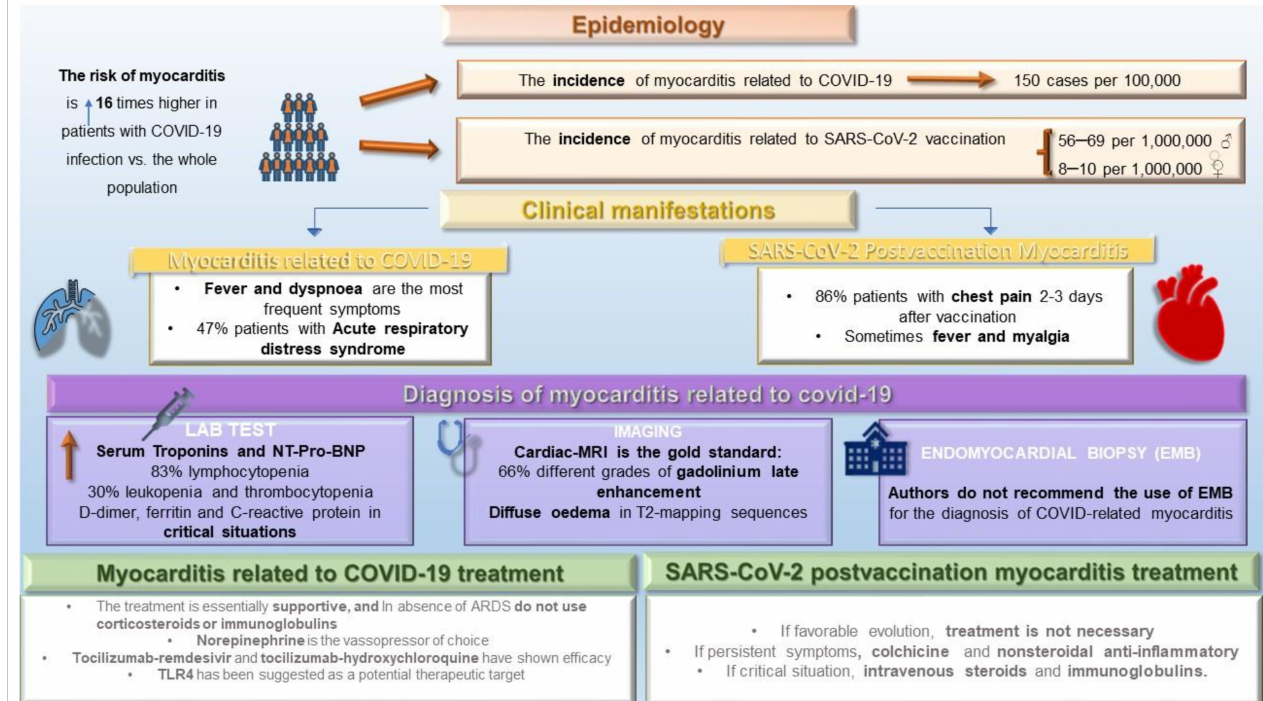
Figure 1. Graphical description of the epidemiology, clinical manifestations, diagnosis, and treat- ment of myocarditis related to COVID-19 and SARS-CoV-2 vaccination. ARDS = acute respiratory distress